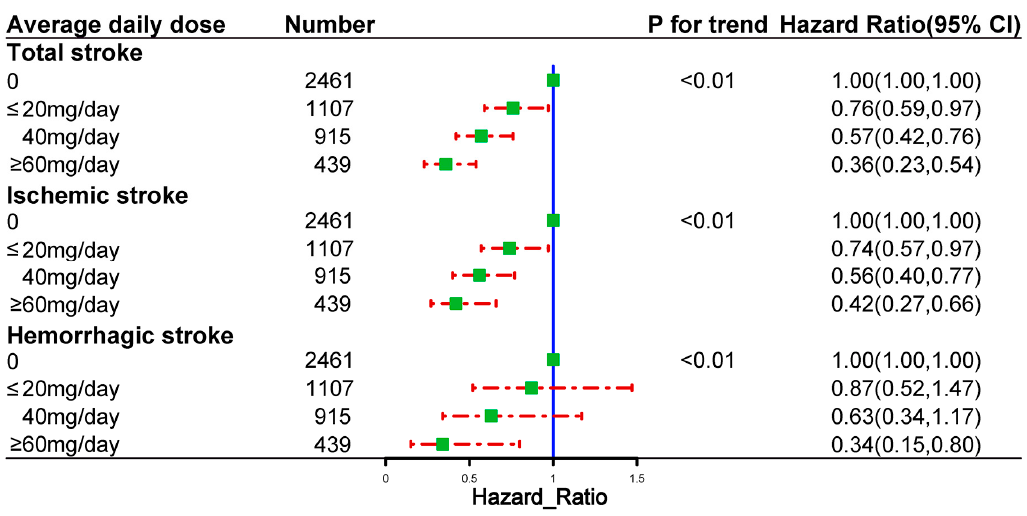
Figure 5. Dose–response relationships between the average daily dose of spironolactone and the risk of outcome events in propensity-score-matched cohort.